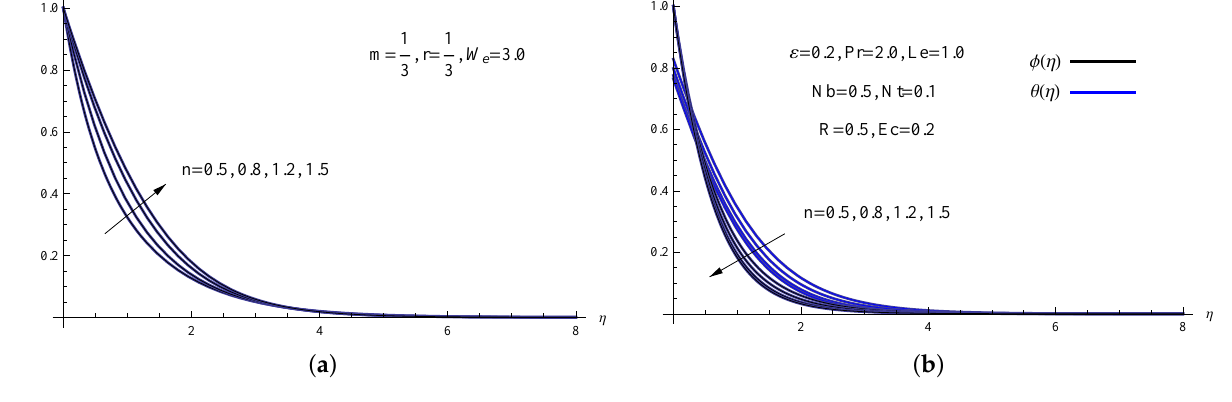
Figure 2. ( a ) f (cid:48) ( η ) via n ; ( b ) θ ( η ) and φ ( η ) via n Figure 2. ( a ) f 0 ( η ) via n ; ( b ) θ ( η ) and φ ( η ) via n .